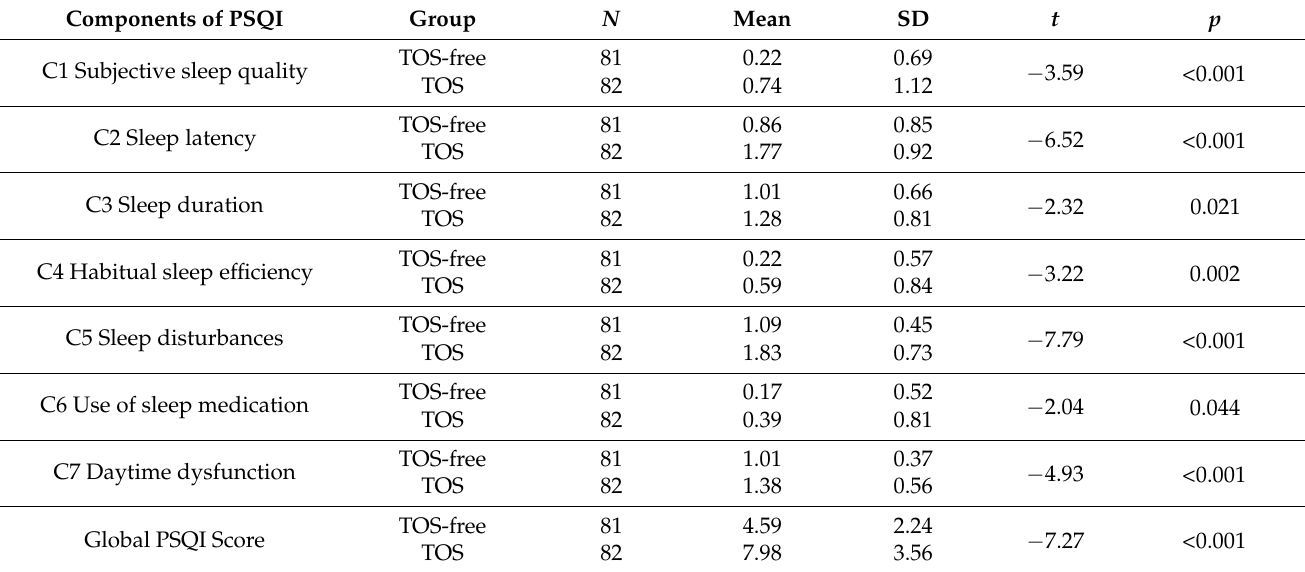
Table 4. Differences in the scores obtained for different PSQI components between TOS and TOS-free group.